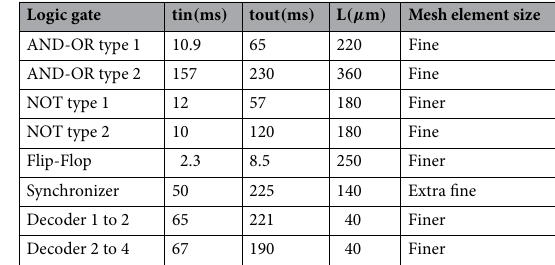
Table 7. Efficiency and meshing element status for each logical gate. t in is average time the first bubble forms, t out is average time the first bubble reaches the outlet, and L is bubble length.